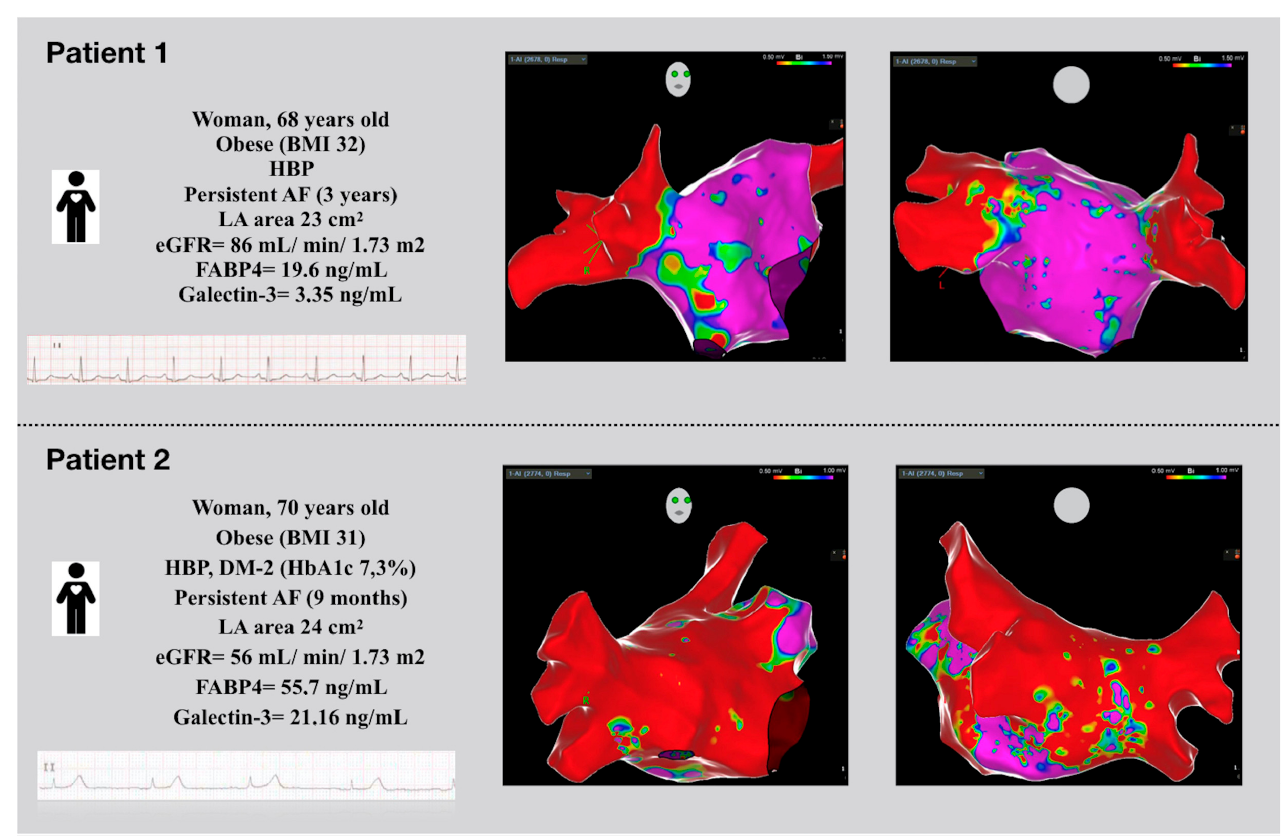
Figure 2. Three-dimensional electroanatomical mapping during catheter ablation. Patient 1: 68 years old, female, with persistent AF, non-elevated FABP4 levels and isolated atrial fibrosis. No recurrence of AF. Patient 2: 70 years old, female, with persistent AF, elevated FABP4 levels and extensive atrial fibrosis. Early recurrence of